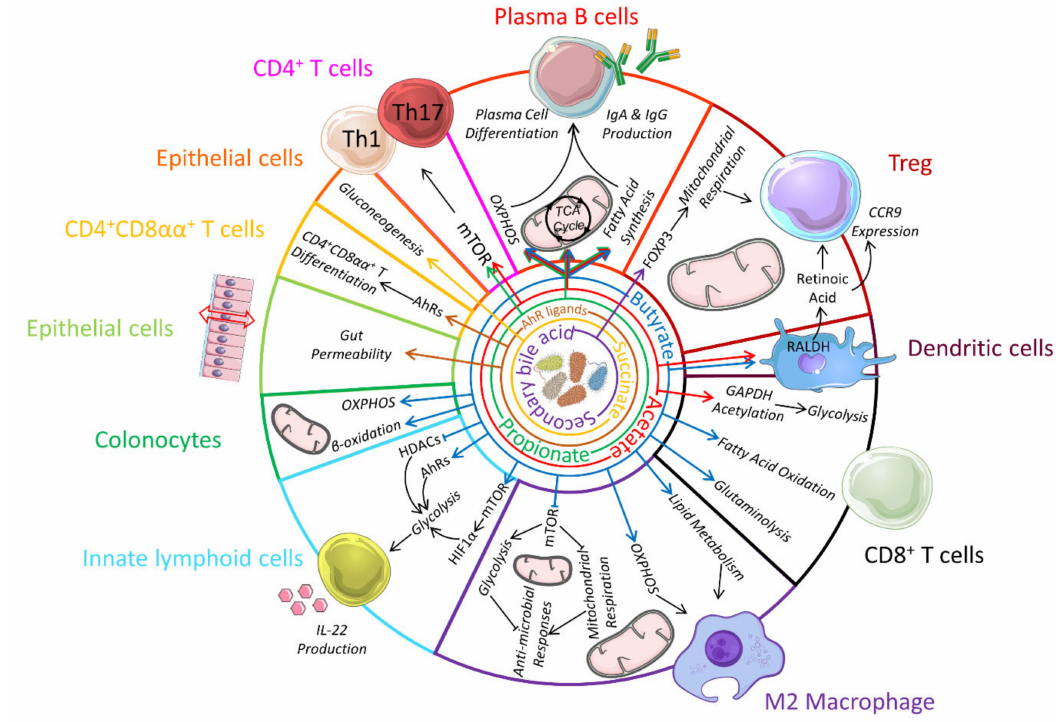
Figure 2. Impact of bacterial-derived metabolites on host immunometabolism and gut immune cell function. Butyrate can be oxidised by colonocytes to generate energy via oxidative phosphorylation (OXPHOS), or to promote metabolic rewiring of immune cells such as M2 macrophages and CD8 + memory T cells towards fatty acid oxidation and OXPHOS. Butyrate also inhibits histone deacetylase (HDAC), and upregulate aryl hydrocarbon (AhR) receptor and hypoxia-inducible factor 1- alpha (HIF-1 α ) expression to promote glycolysis in innate immune cells to drive their production of IL-22. Acetate and propionate induces Th1/Th17 differentiation by activating the mechanistic target of rapamycin (mTOR), while acetate and butyrate promote regulatory T cell (Treg) differentiation by enhancing retinaldehyde dehydrogenase (RALDH) enzyme activity in tolerogenic dendritic cells to produce retinoic acid. Retinoic acid also induce the gut homing receptor C-C chemokine receptor type 9 (CCR9) in Treg. Acetate also enhances memory CD8 + T cell effector function by enhancing glyceraldehyde 3-phosphate dehydrogenase (GAPDH) enzyme activity to drive glycolysis. Butyrate, acetate and propionate can promote plasma B cell differentiation and antibody production by activating OXPHOS and fatty acid synthesis, and to promote immunoglobulin A (IgA) and immunoglobulin G (IgG) production. In the gut, succinate act as a substrate for gluconeogenesis in epithelial cells, and may also potentially serve as a pro-inflammatory molecule (not shown). Secondary bile acids, such as 3-oxo lithocholic acid, can directly induce the differentiation ROR γ t Treg in the colon